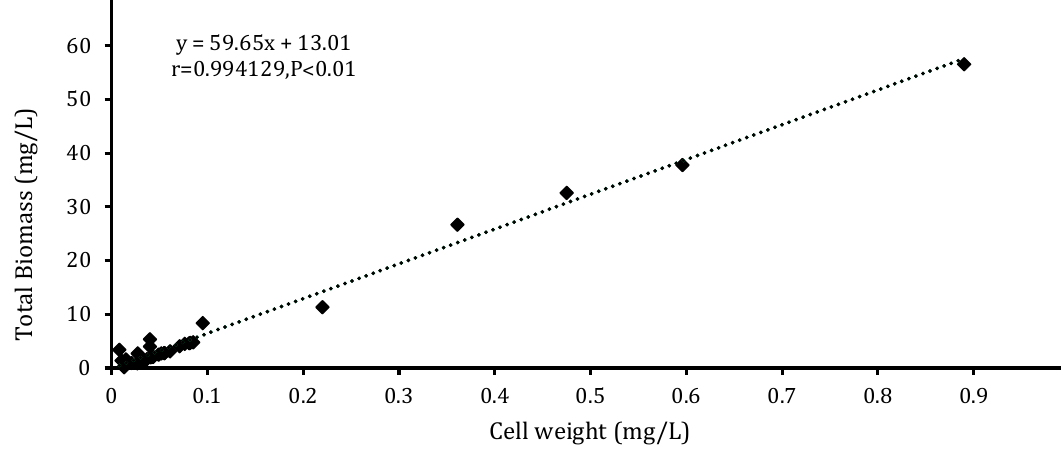
Figure 7: Correlation coefficient (r) of total biomass (mg/L) of S. platensis with cell weight (mg/L) of spirulina grown in supernatant of DRMM and KM.